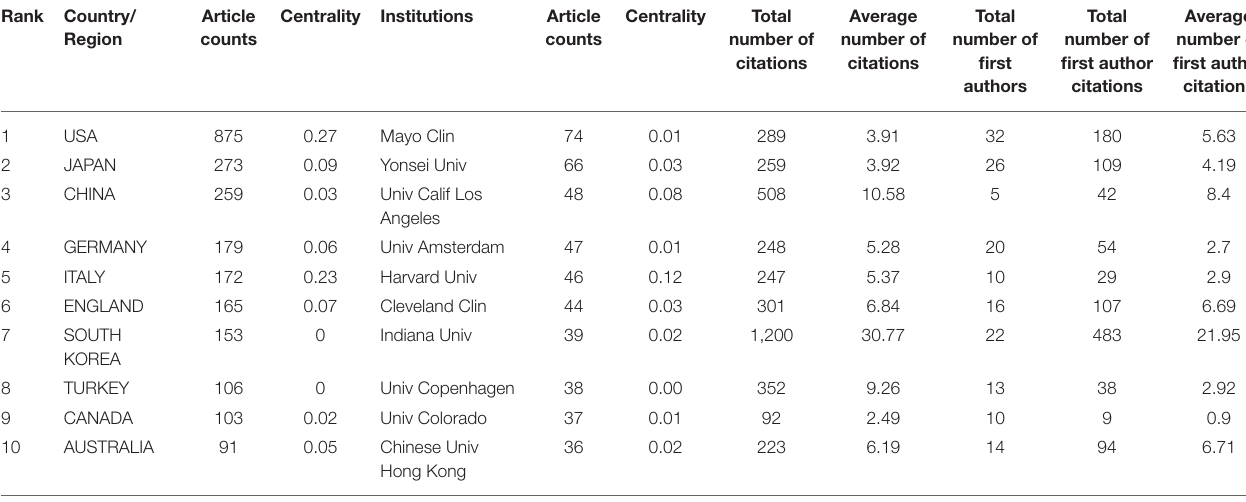
TABLE 1 | The top 10 countries/regions and institutions contributing to publications in Endoscopic Sedation research. Rank Country/ Region